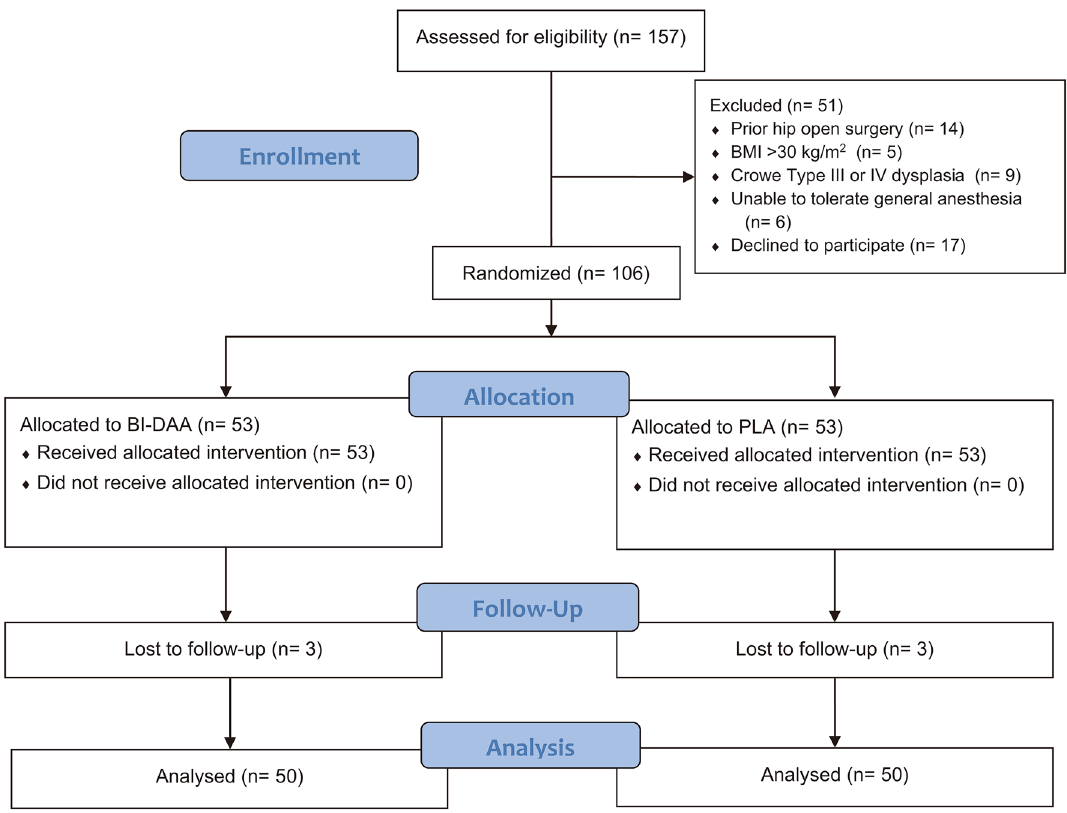
Figure 1. Flow diagram illustrating patient selection, randomization, follow-up, and data analysis throughout the study. BI-DAA, bikini-incision via direct anterior approach; PLA, posterolateral